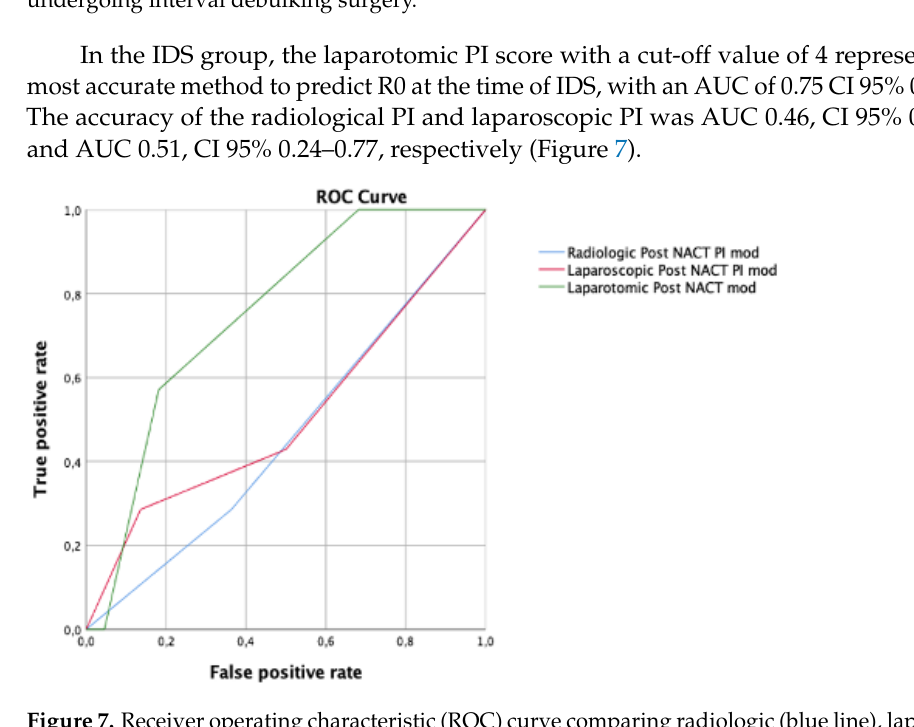
Figure 6. Agreement between laparotomic and radiologic peritoneal cancer index (PCI) in women undergoing interval debulking surgery. undergoing interval debulking surgery.